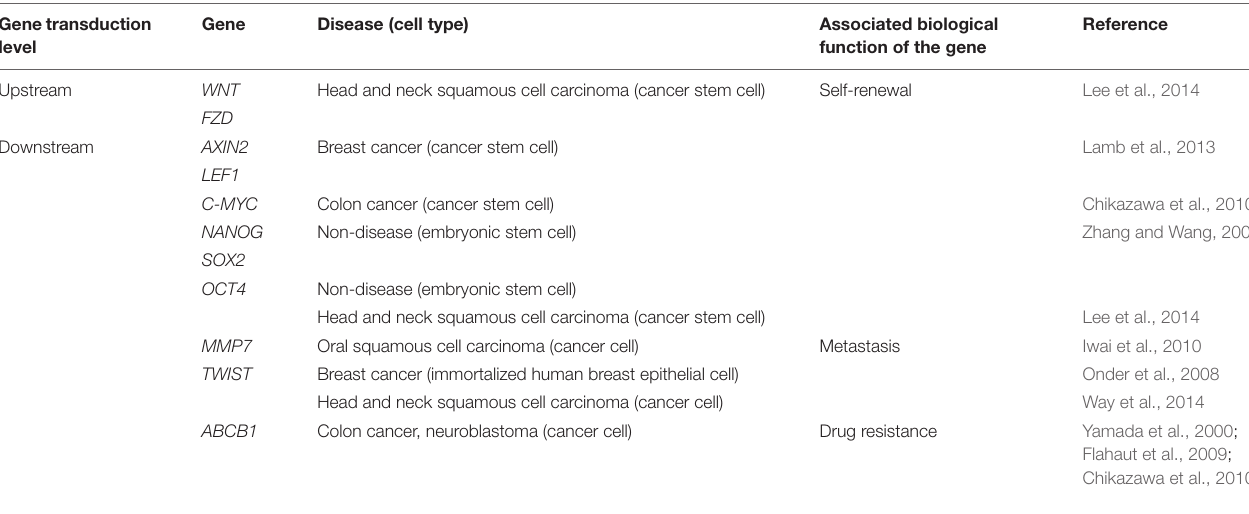
TABLE 2 | Elevated expression of upstream and downstream of Wnt signaling pathway genes and their associated diseases. Genetransduction